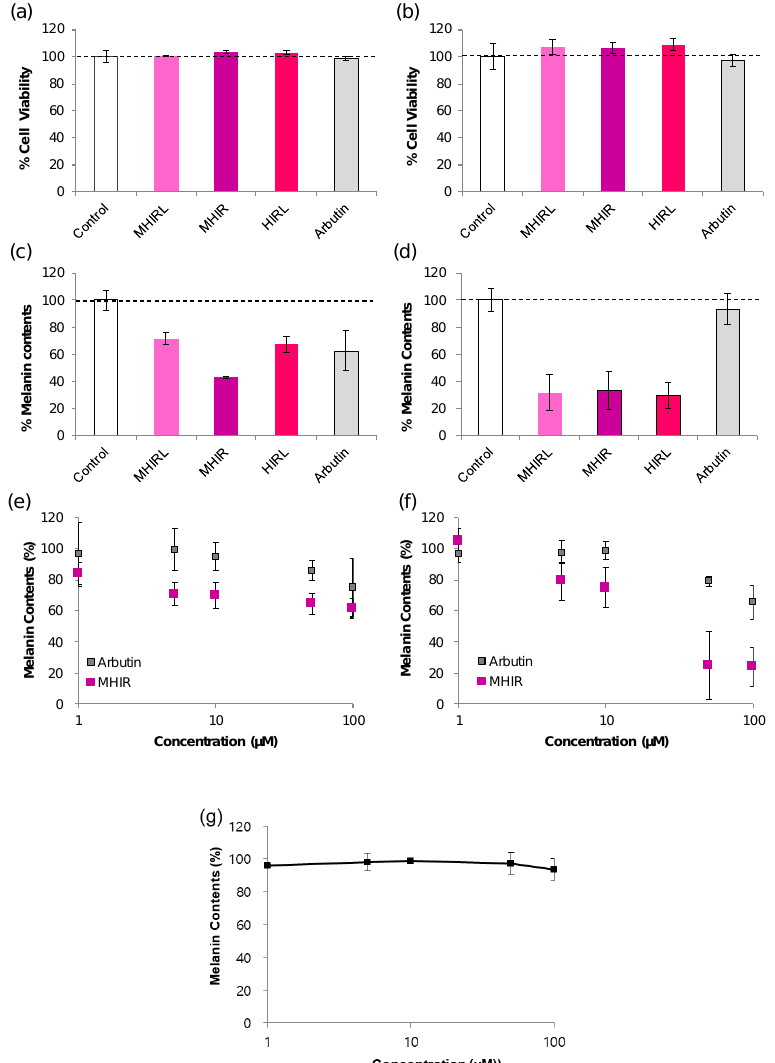
Figure 4. Hypopigmenting activity of methionine-histidine-isoleucine-arginine-leucine (MHIRL) family peptides in melanocytes. The e ff ects of MHIRL family on cell viability ( a ) in Mel-Ab cells and ( b ) in B16F10 cells. [peptide] = 100 µ M. The melanogenesis inhibitory activities of the MHIRL family ( c ) in Mel-Ab cells and ( d ) in B16F10 cells. [peptide] = 100 µ M. The melanogenesis inhibitory activities of MHIR ( e ) in Mel-Ab cells and ( f ) in B16F10 cells. ( g ) Remaining melanin contents (%) in α -MSH treated B16F10 cells with N -terminal acetylated MHIR (Ac-MHIR) at various